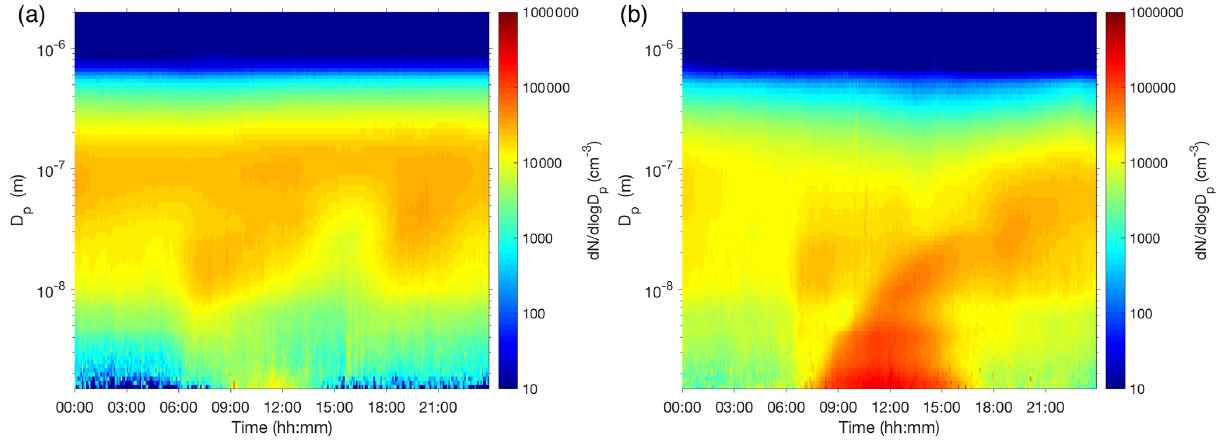
Figure 3. Average diurnal variation in particle number concentration size distributions (a) on days without NPF events and (b) on NPF event